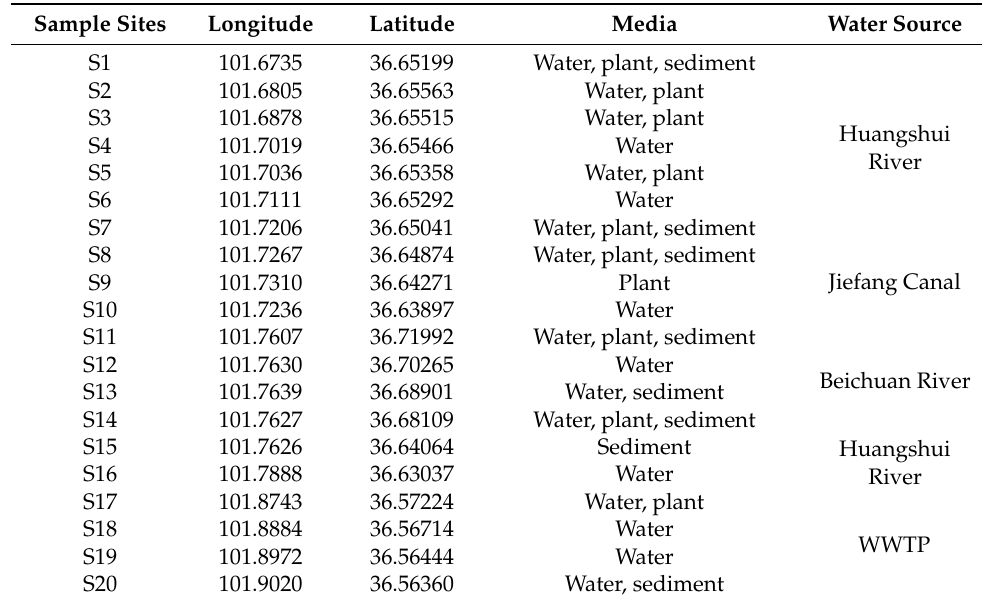
Figure 1. HNWP and sampling sites. ( a ) Haihu wetland, ( b ) Beichuan wetland, ( c ) Huoshaogou wetland, ( d ) Huangshui River, ( e ) Ninghu wetland. Table 1. Information on latitude, longitude, and type of sampling